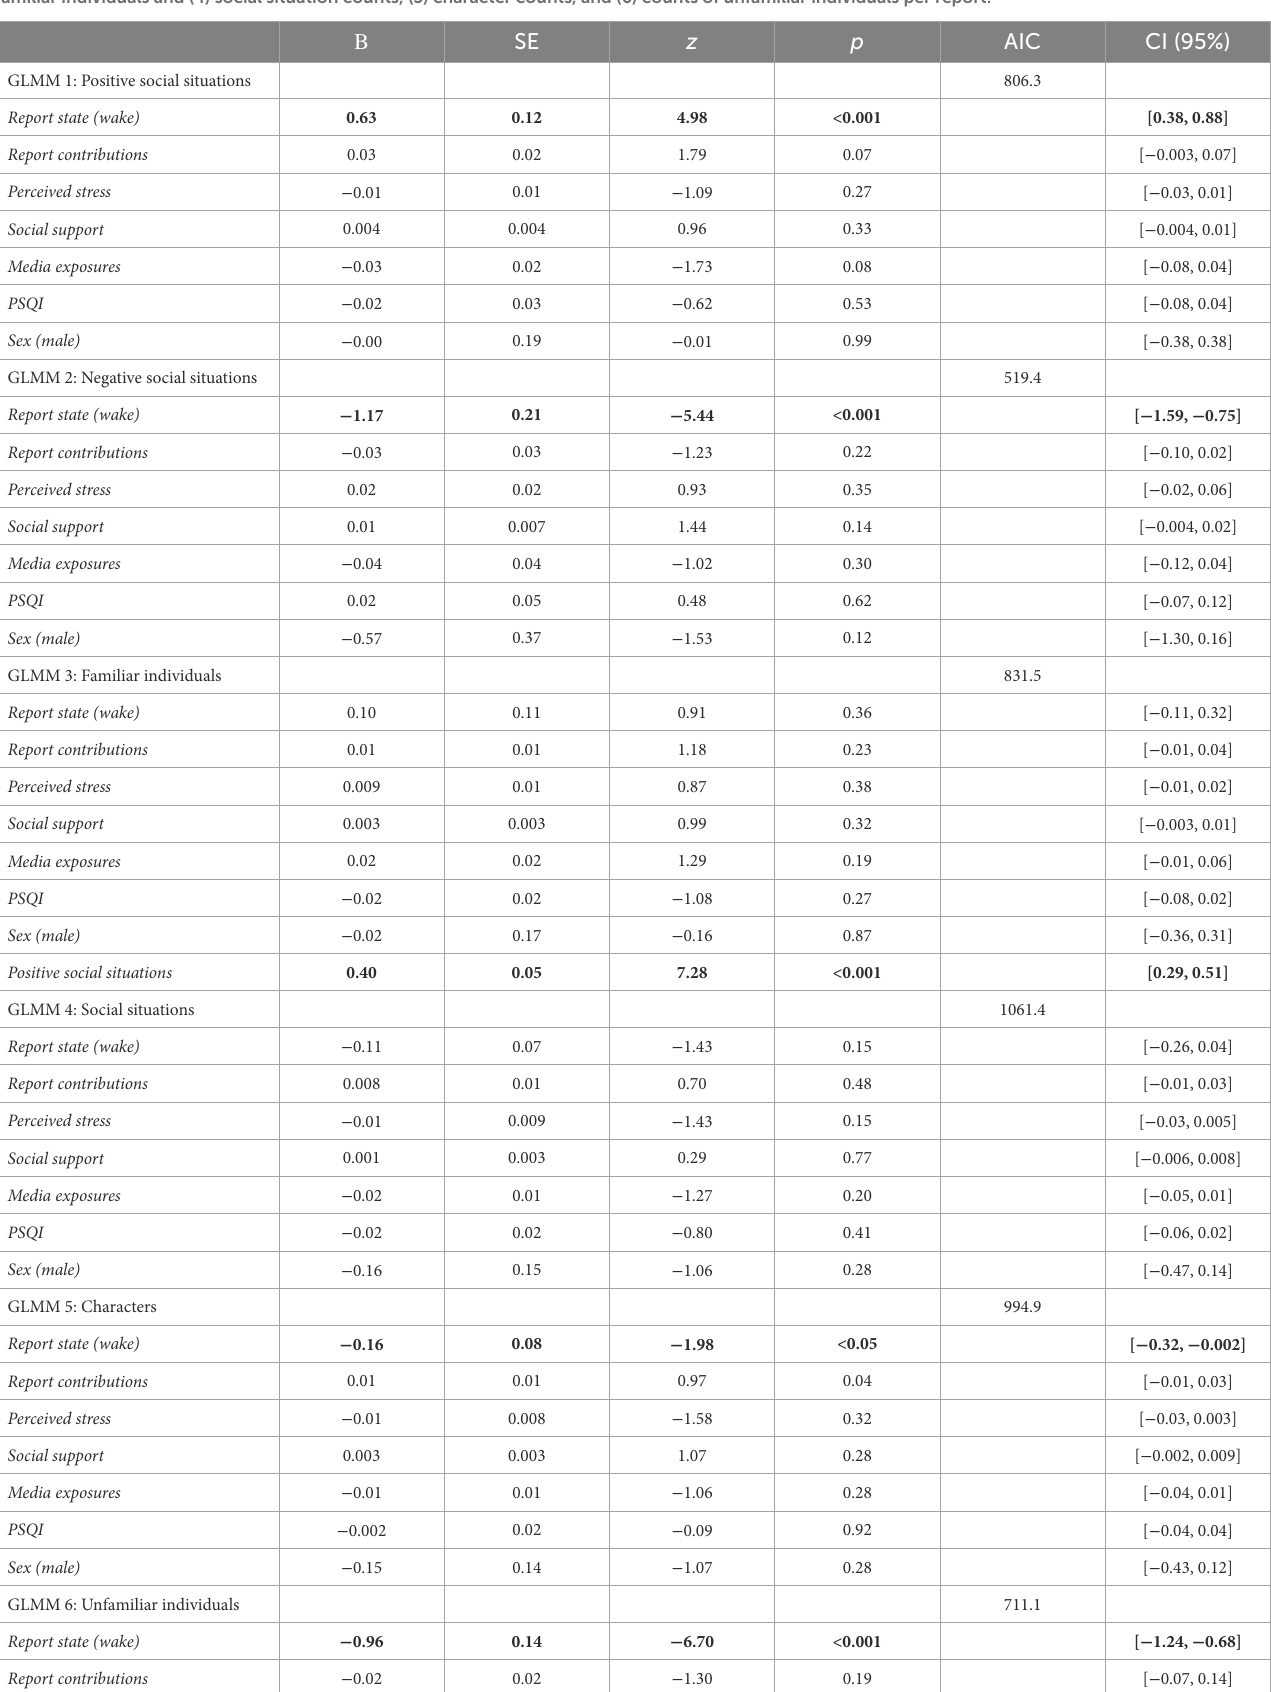
TABLE 1 Six GLMMs were introduced as a function of number of (1) counts of positive social situations, (2) counts of negative social situations, (3) counts of familiar individuals and (4) social situation counts, (5) character counts, and (6) counts of unfamiliar individuals per